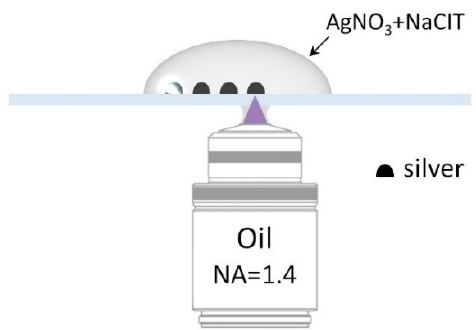
Figure 6. Geometry of the photochemical deposition of silver on a glass substrate. The glass coverslip